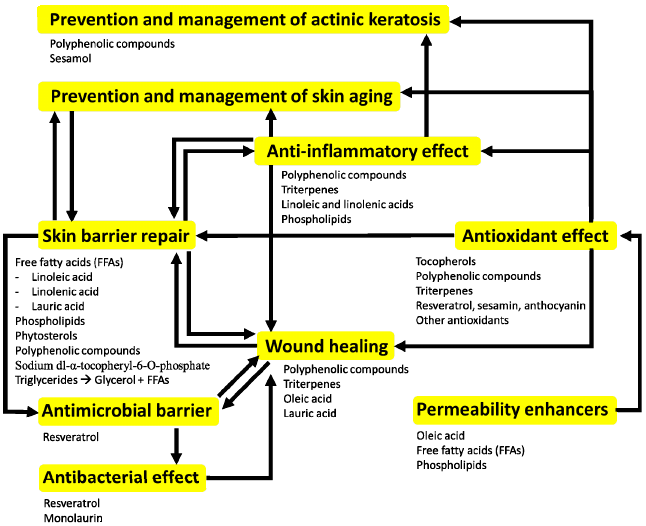
Figure 1. The potential benefits of plant oil topical application are diverse. Physiological responses are a result of the interaction between the bioactive compounds and the pathophysiological context of the skin.